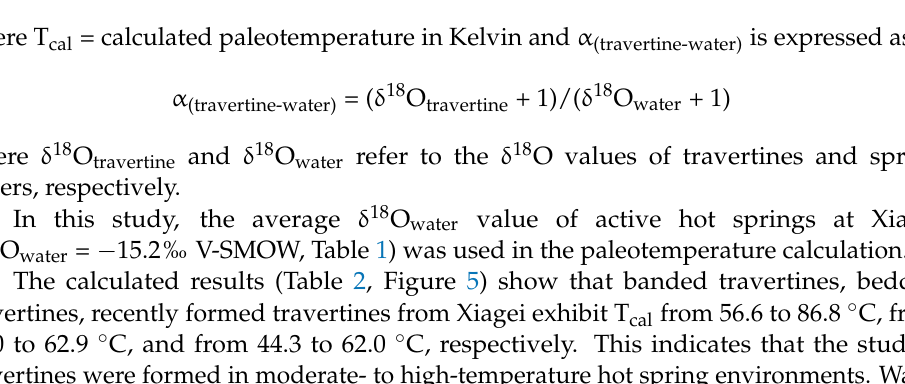
Figure 5. Diamond box plots showing the relationships between lithotypes and δ 13 C ( A ), between lithotypes and δ 18 O ( B ), between lithotypes and T cal ( C ), and between lithotypes and δ 13 C parent CO2 ( D ) . thick-laminated crystalline crust (TP), thin-laminated composite crystalline crust (TC), bedded travertines (BT) and recently formed travertines (RFT). Horizontal dark lines referred to the median values, while dot-dash lines referred to the mean